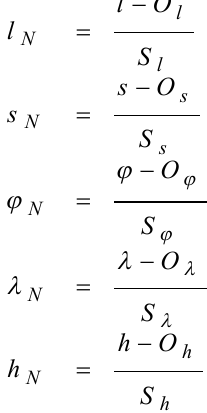
Figure 5. Projection of PSS and MSS sensors on earth